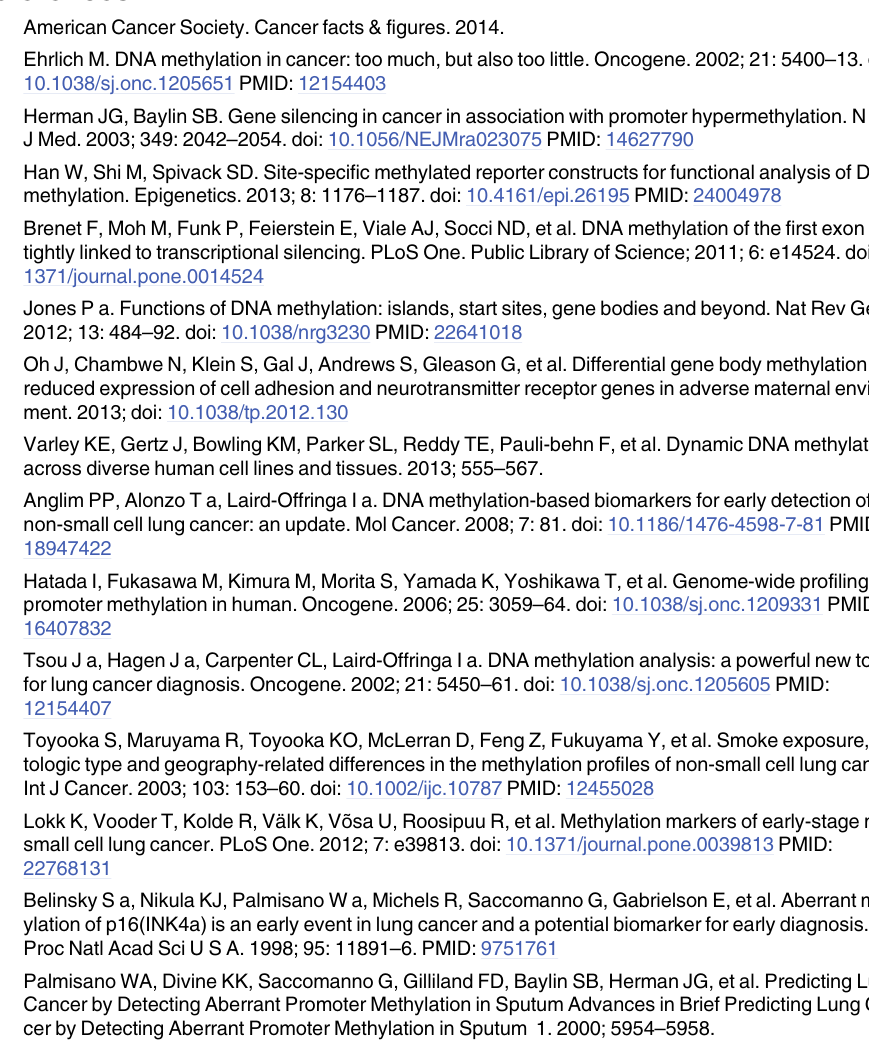
S7 Table. Discrimination Stability of DM Loci